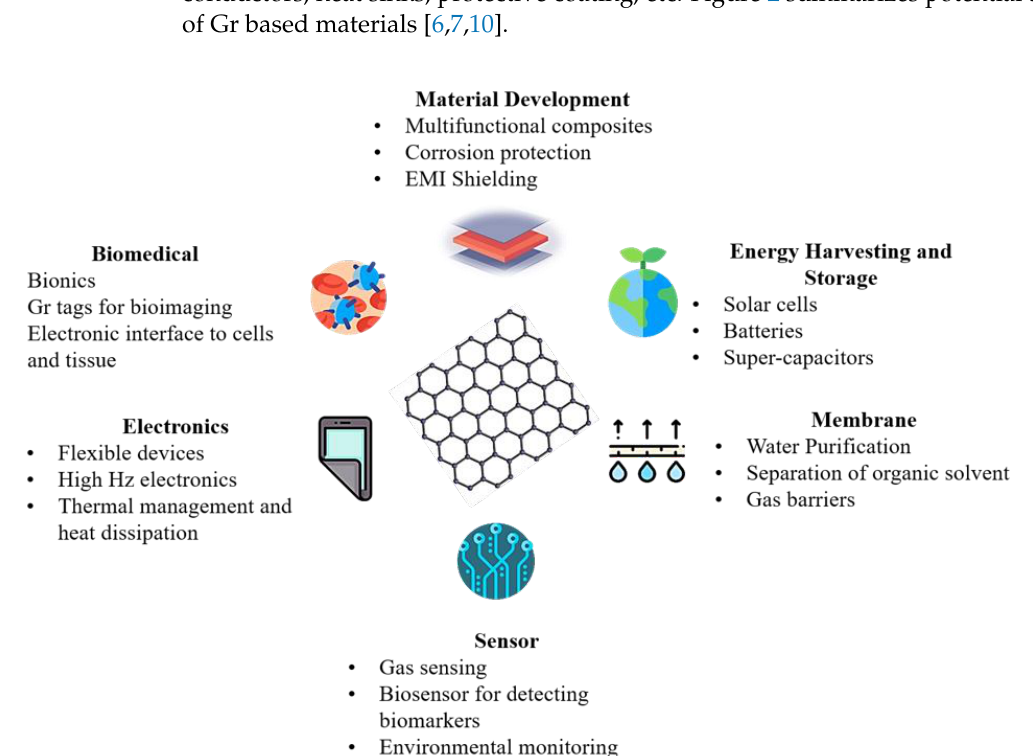
Figure 2. Schematic summarizing applications of graphene (Gr)-based materials.